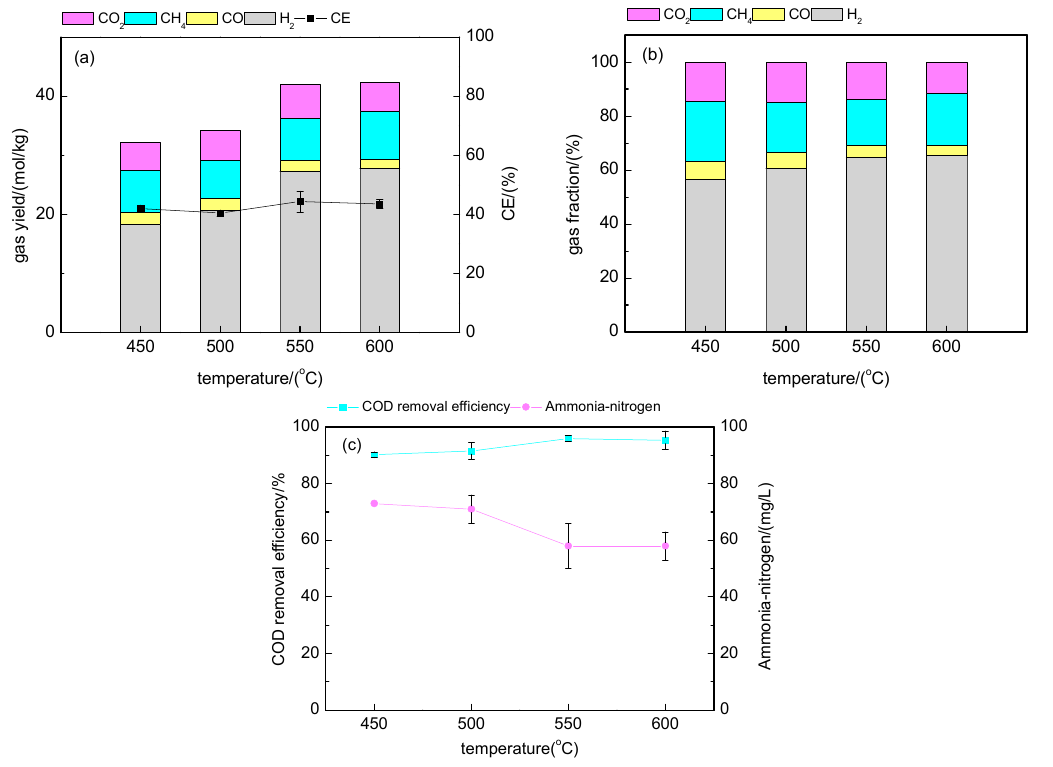
Figure 1. Effect of temperature on gasification characteristic: ( a ) gas yield and CE ( b ) gas fraction ( c ) COD removal efficiency and ammonia nitrogen (23 MPa, residence time 20 min). ( c ) COD removal efficiency and ammonia nitrogen (23 MPa, residence time 20